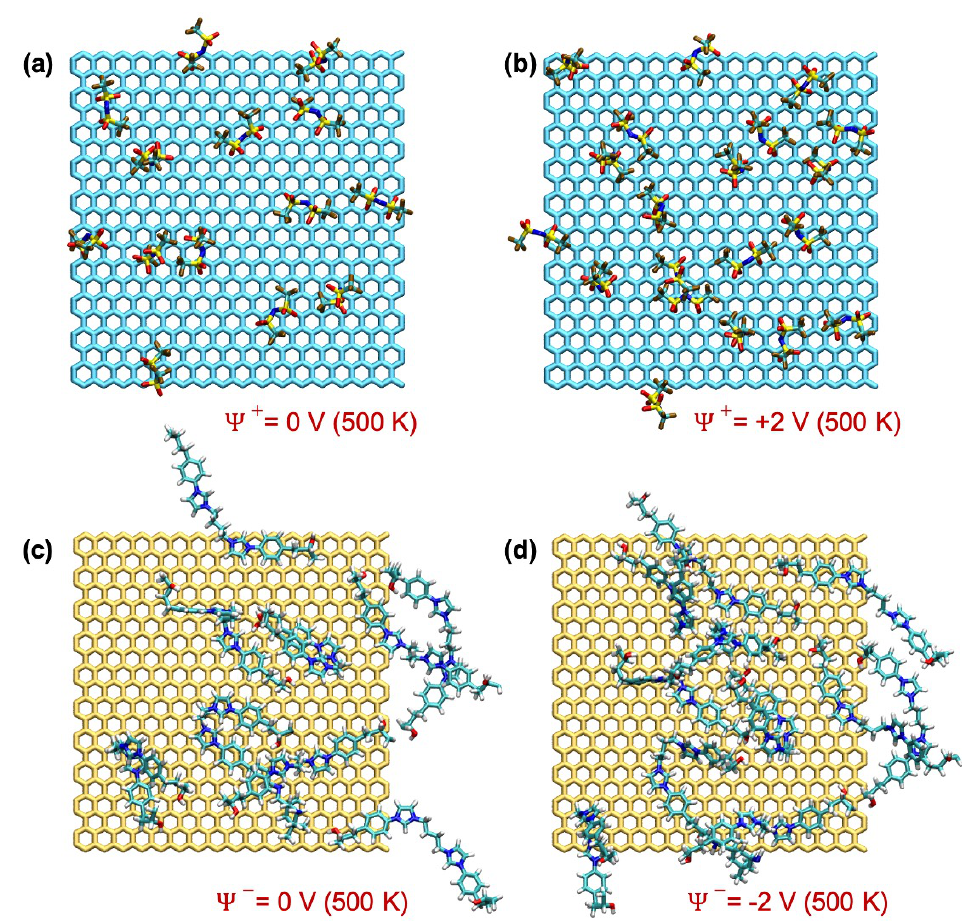
Figure 7. Snapshots taken at 500 K at various ∆Ψ showing ( a , b ) the anions on the positive electrode and ( c , d ) the polymer network on the negative electrode, found within a distance of 6